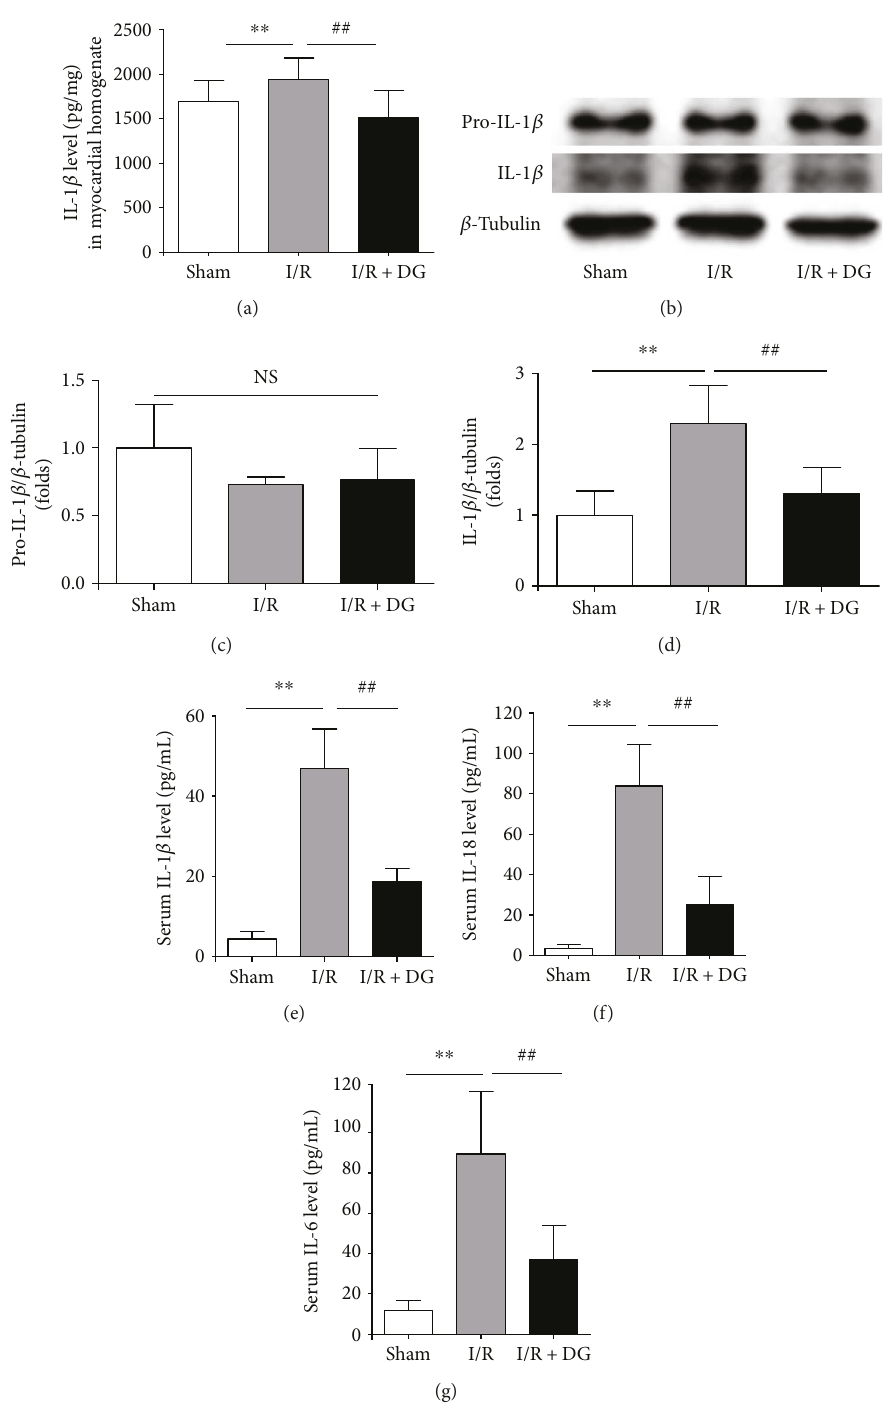
Figure 5: Dunye Guanxinning reduced maturation and release of IL-1 β . (a) IL-1 β level in the damaged myocardial homogenate of rats (each n = 8 ); (b – d) Immunoblot levels of pro-IL-1 β and IL-1 β in the left ventricular tissue (each n = 4 ); (e – f) serum IL-1 β , IL-18, and IL-6 levels in rats ( n = 8 ). Data are expressed as mean ± SD. ∗∗ P < 0 01 versus sham operation group; ## P < 0 01 versus ischemia-reperfusion